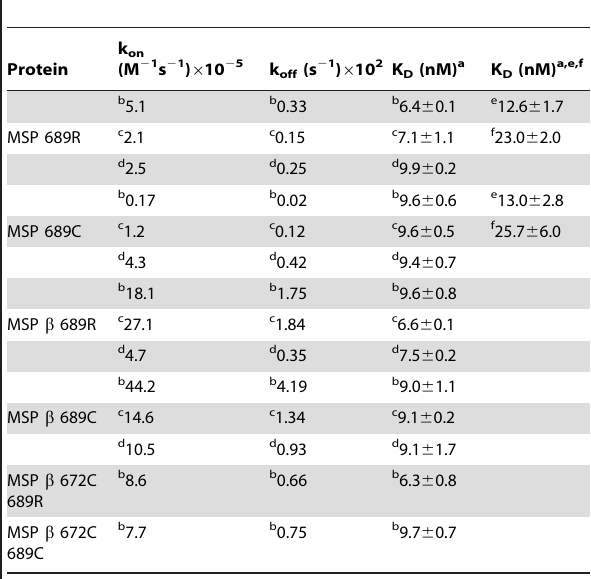
Figure 5. The 689C polymorphism does not affect proteolytic activation of MSP by hepsin. Purified MSP 689R (upper panel) and MSP 689C (lower panel) consisting of both pro-MSP and MSP were mixed with 100 nM to 97 pM hepsin in a 2-fold dilution series and analyzed by gel electrophoresis under reducing conditions. Relative mobilities corresponding to pro-MSP, MSP a , and MSP b are indicated. Data are representative of three independent experiments.